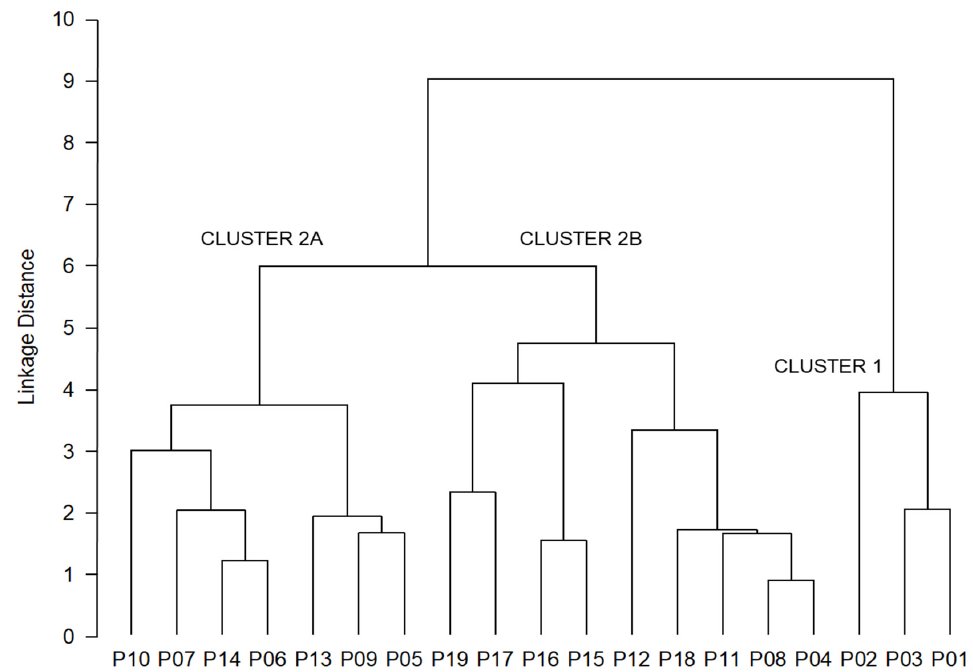
Figure 2. Tree diagram of the 19 Pyrus pyraster populations studied. The unweighted pair-group method with arithmetic mean (UPGMA) was used to join the clusters, and the Euclidean distance to define the distance between the studied populations based on 10 phenotypic traits.